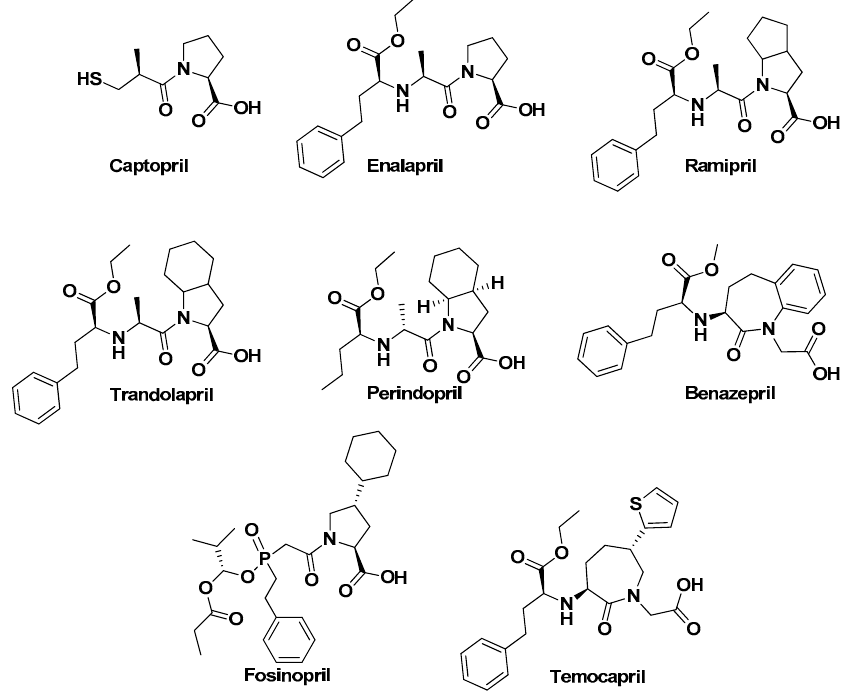
Figure 3. Structures for the eight selected angiotensin-converting enzyme inhibitors.